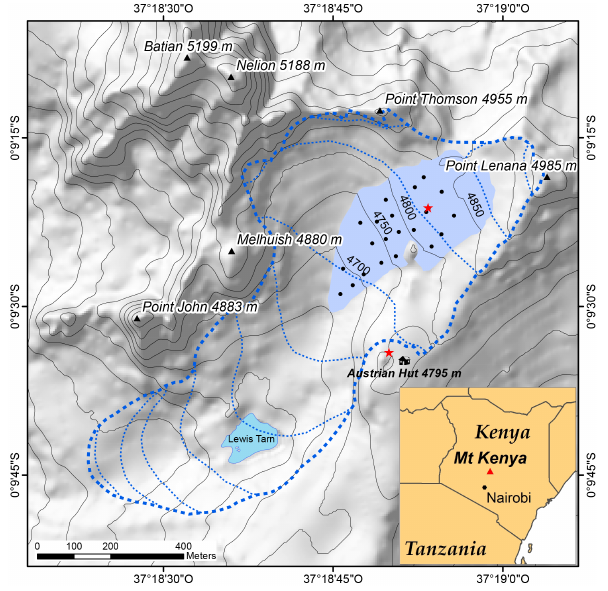
Figure 1. Overview map of LG, Mt. Kenya, for 2010 (0.1km 2 ) and the late 19th century (L19, 0.6km 2 , dashed). Red stars denote AWS locations, black dots the ablation stakes. L19 outline from Patzelt et al. (1984) with reconstructed contour lines. Off-glacier contours were taken from Schneider (1964) and updated for the LG basin in 2010 (Prinz et al., 2012). The mean wind direction for the depicted weather stations is south-east, invariant over the course of the year.